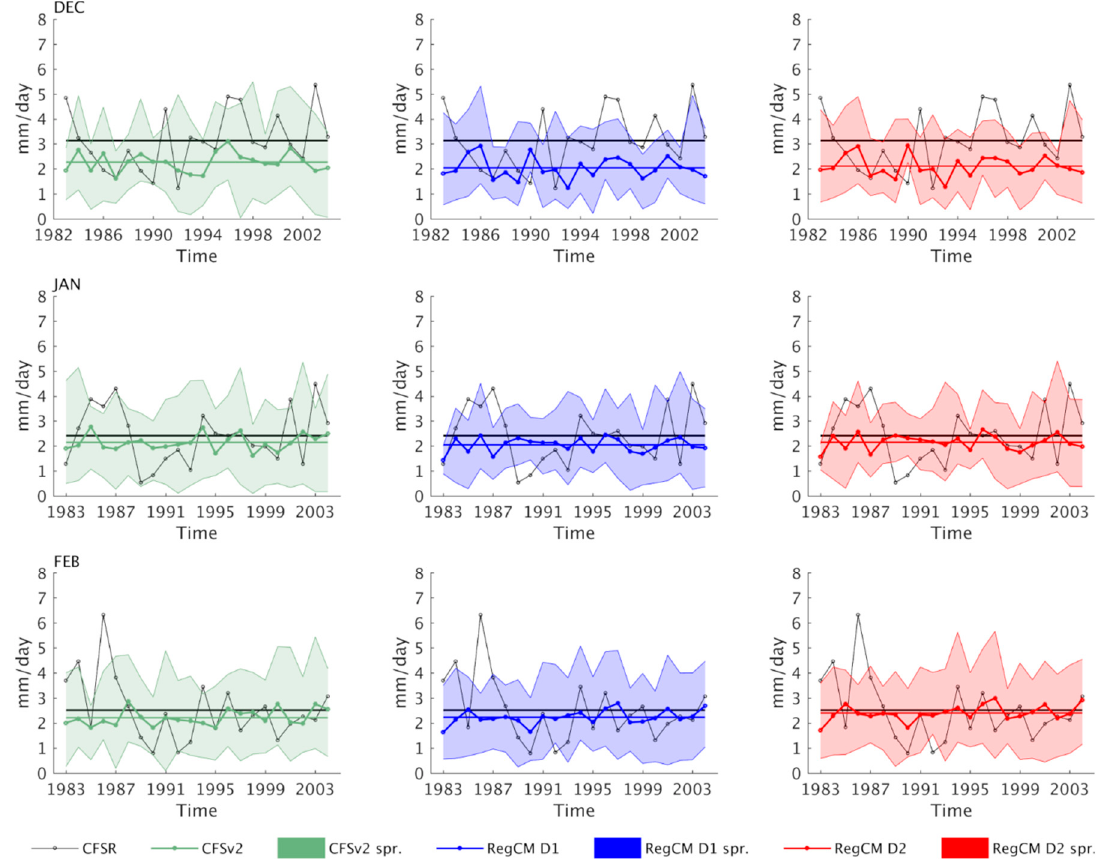
Figure 11. The same as in Figure 4 but for the precipitation.